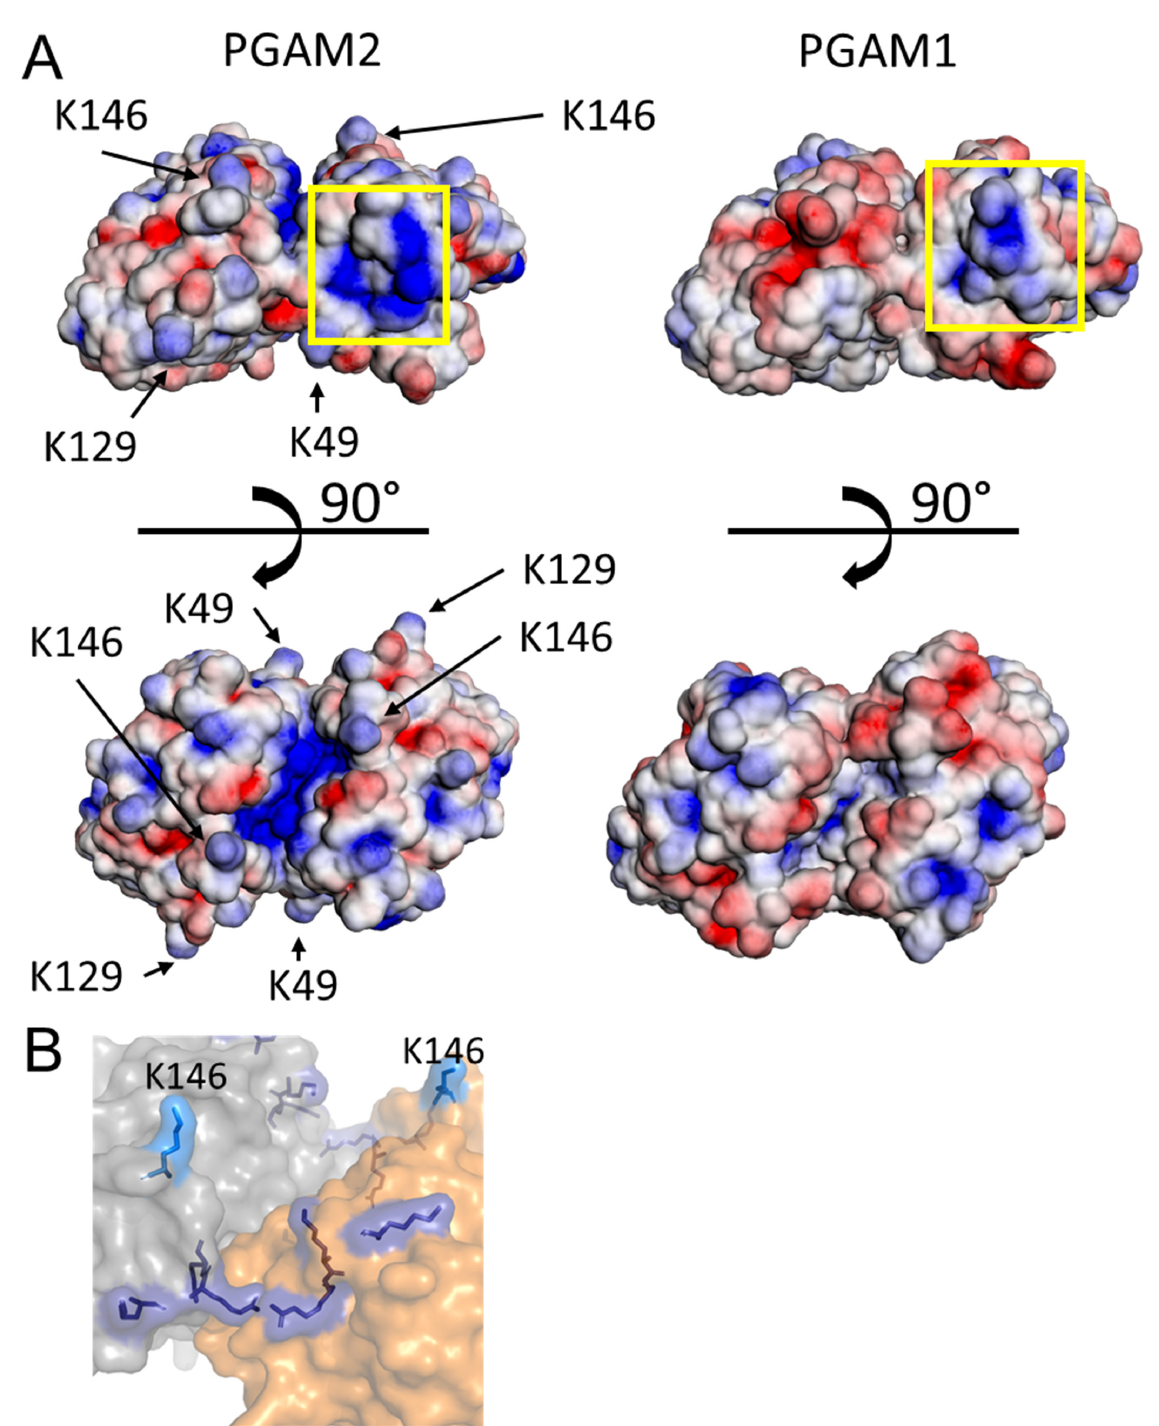
Figure 3. Lysine residues potentially engaged in nuclear import of PGAM2. ( A ) Solvent accessible surface potential of PGAM1 (PDB ID 4GPI) and PGAM2, colored from -3 kT/e (red) to 3 kT/e (blue). Calculated by APBS [20]. Yellow box—positive surface patch common to both PGAM1 and PGAM2. ( B ) Proposed NLS of PGAM2: orange, gray—subunits of the PGAM2 homodimer, light blue—K146 residue necessary for proper nuclear import, present in PGAM2 but not PGAM1, dark blue—positively charged residues in the vicinity of K146, conserved in both PGAM1 and PGAM2 (K138, R140, R141, K176, K179,